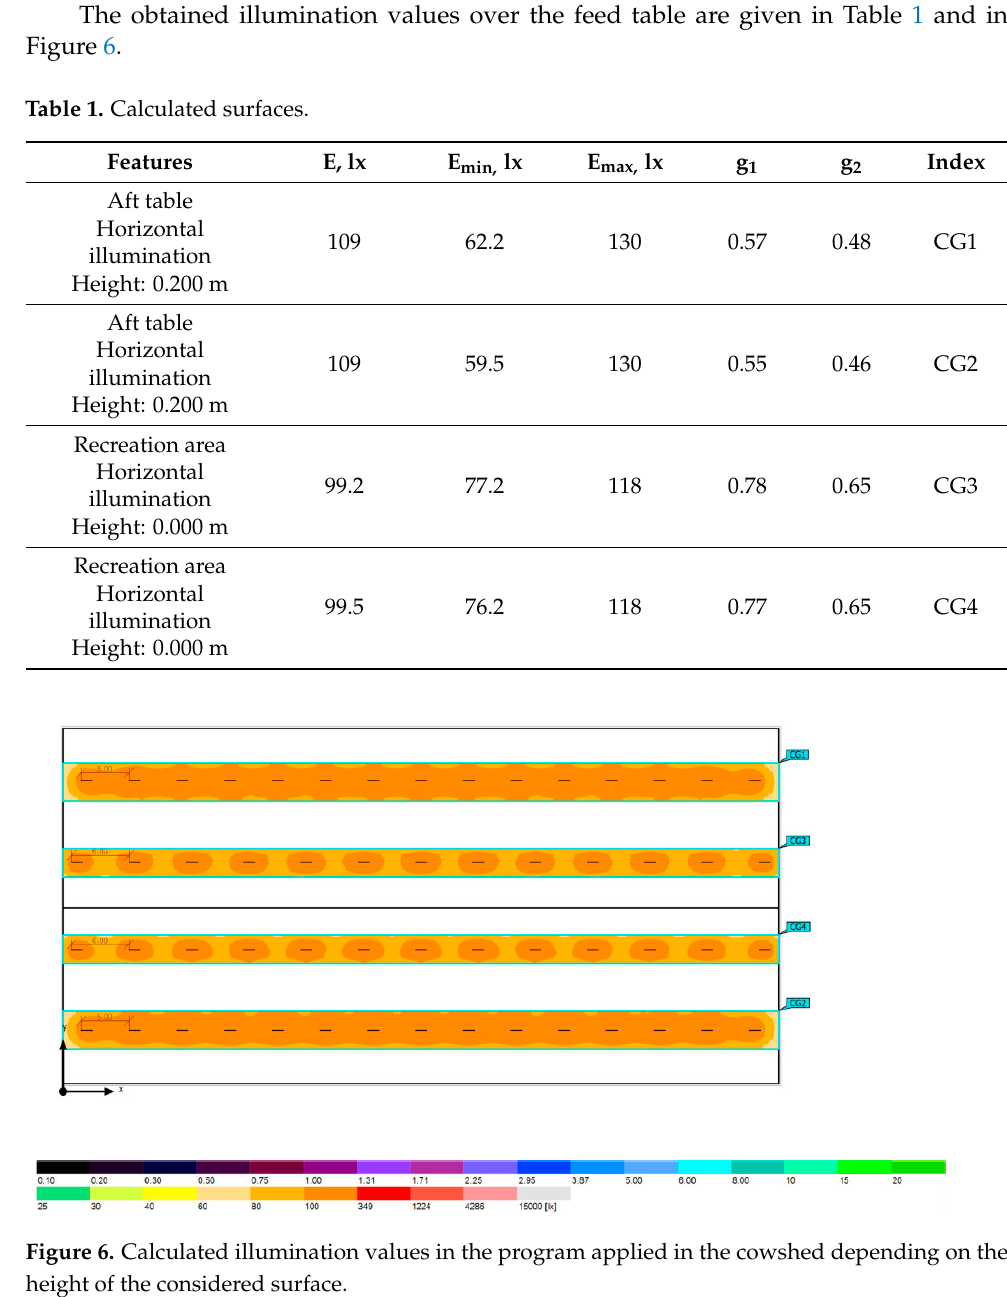
Index Aft table Horizontal illumination Height: 0.200 m CG1 Aft table Horizontal illumination Height: 0.200 m